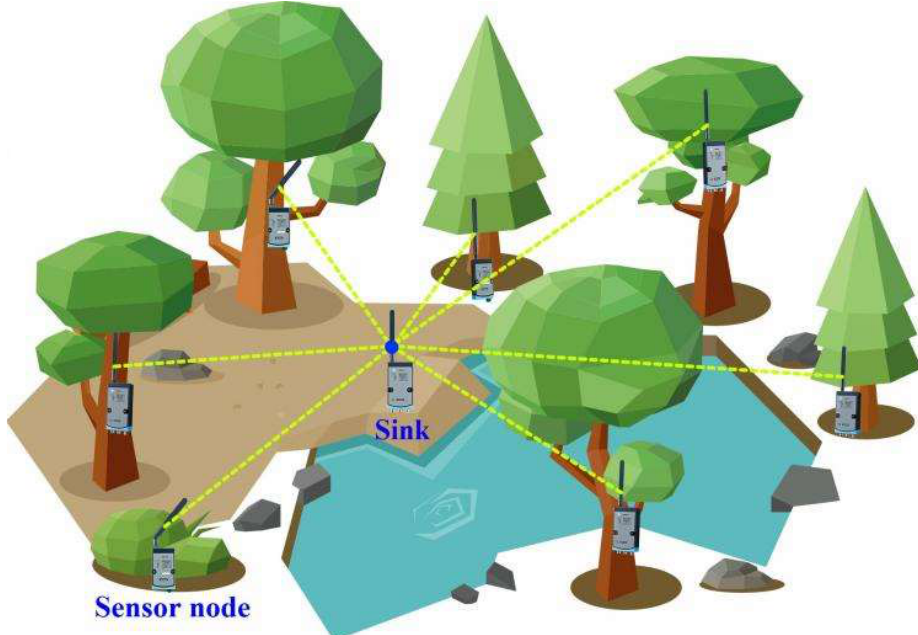
Figure 1. Schematic diagram of the basic architecture of forestry IoT system.